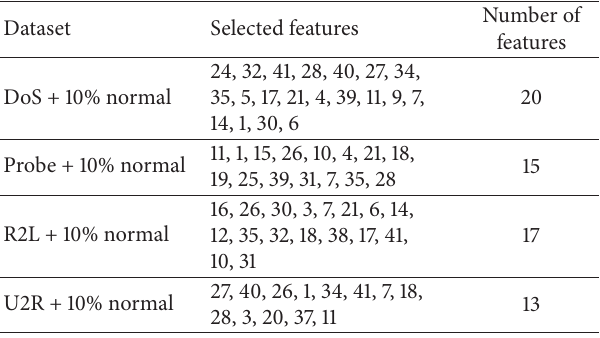
Table 5: List of features selected using SFSM methods.